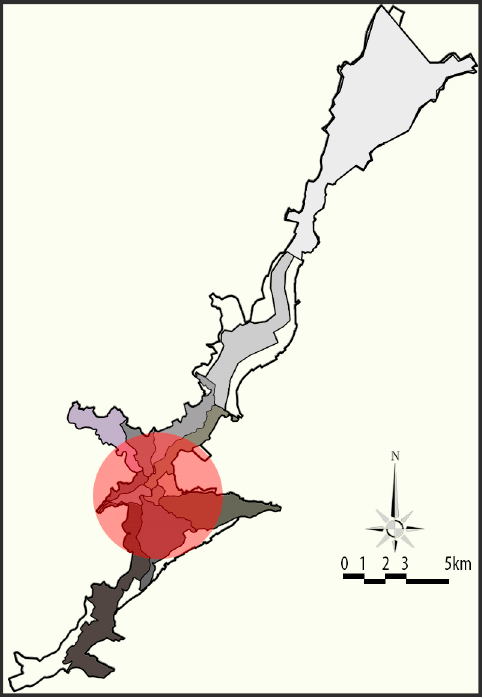
Figure 1. The location of the places where a traditional construction system is seen in the city of Bitlis.